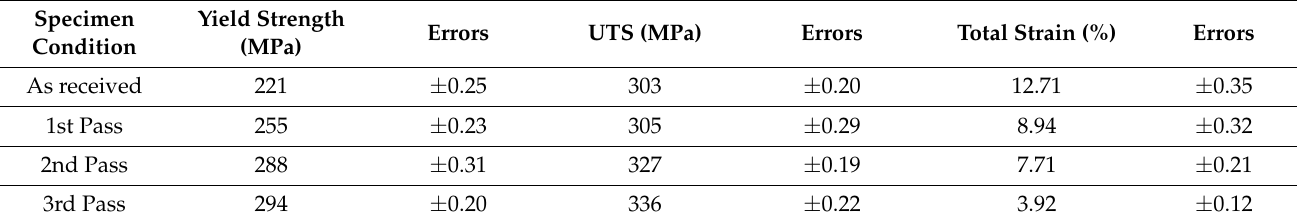
Table 2. Tensile properties of Al 5083 alloy before and after